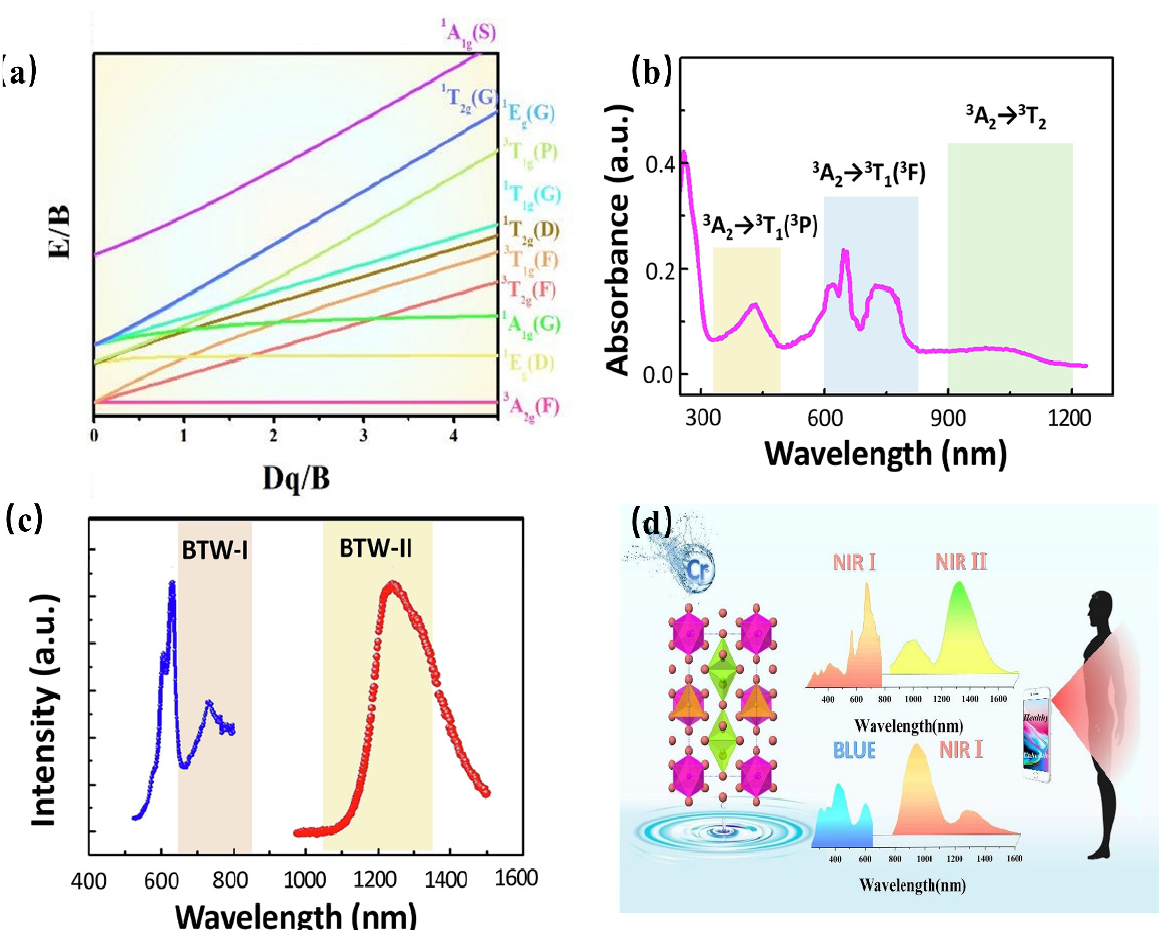
Figure 18. ( a ) Energy-level diagram for Cr 4+ . ( b ) Absorption spectra of Ca 2 Al 2 SiO 7 : Cr 4+ . ( c ) PL spectra of Ca 2 Al 2 SiO 7 : Cr 4 (Ex = 710 nm and Em = 1230 nm). ( d ) PLE and PL spectra of Mg 14 Ge 5 O 24 : Cr 3+ , Cr 4+ (Ex = 420 nm and Em = 1240 nm).